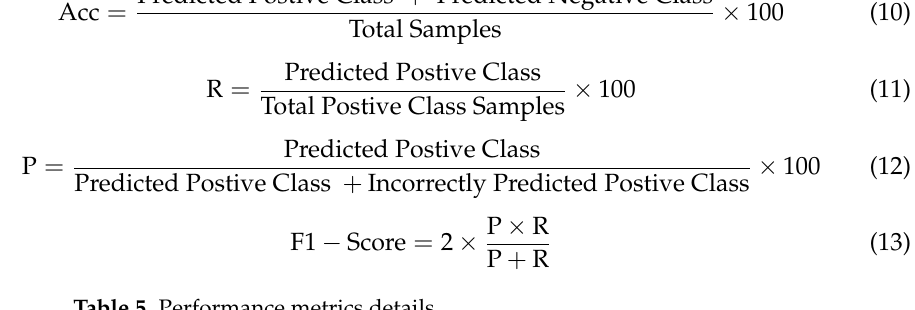
Table 5. Performance metrics details.